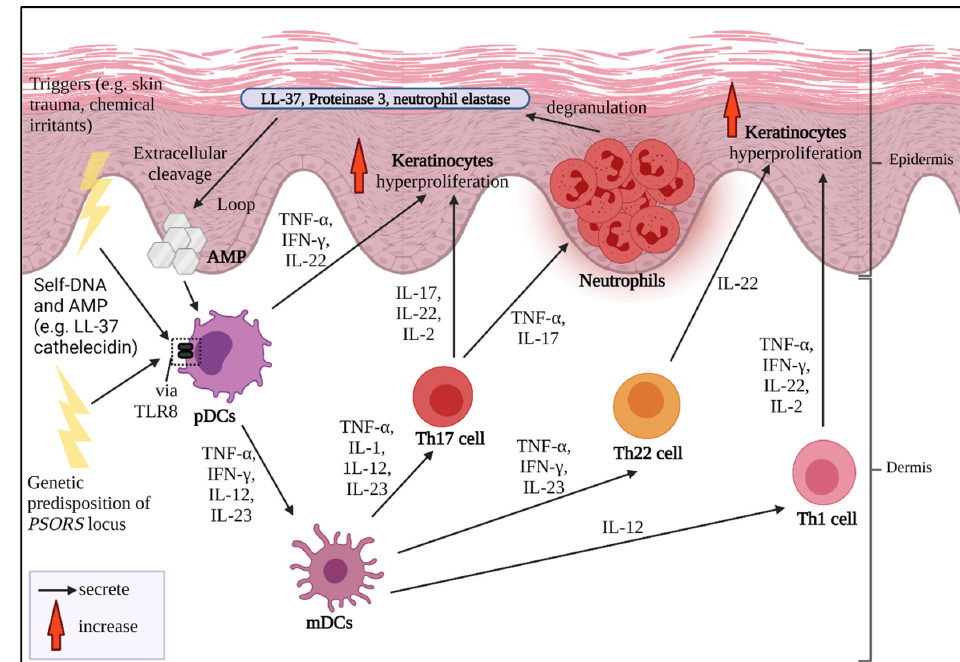
Figure 1. The summarized pathogenesis of psoriasis. Upon triggers, pDCs receive the signal via TLR8 and present the antigens to mDCs. mDCs activate Th1 and Th22 cells to release cytokines to generate hyperproliferative keratinocytes in the epidermis region. mDCs also present cytokines to Th17 cells to initiate keratinocyte hyperproliferation and the assembling of neutrophils to create Munro’s microabscesses. It is thought that once neutrophils undergo degranulation, this produces granular compounds, such as LL-37 and proteinase 3, which create an information loop to be detected again by pDCs. The cycle repeats. (AMP: antimicrobial proteins; PSORS : psoriasis susceptibility loci).